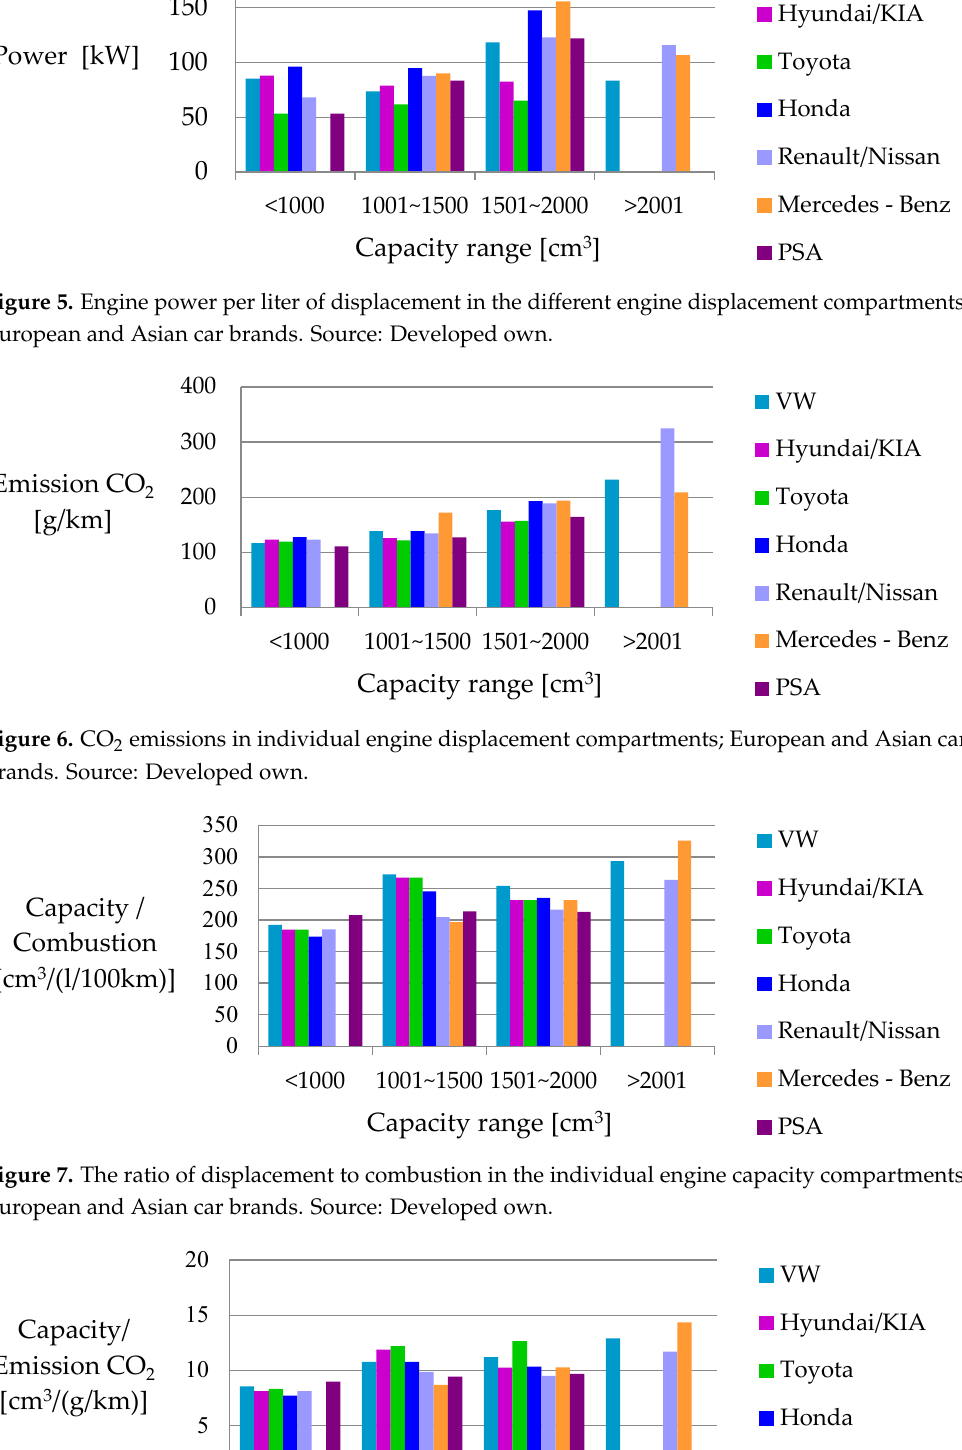
brands. Source: Developed own.